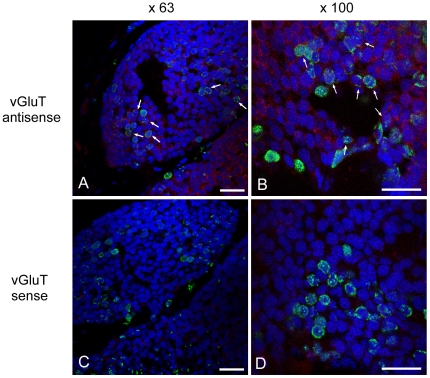
Double staining of BrdU and vGluT mRNA.(A, B) Confocal images of sections dually stained by anti-BrdU antibody (green) and an antisense riboprobe against vGluT mRNA (red). Nuclei were stained with DAPI (blue). Arrows indicate BrdU-positive nuclei surrounded by a vGluT signal as demonstrated by in situ hybridization. (C, D) No signal is detected by a sense probe against vGluT mRNA. Magnifications of objective lenses were 63× (A, C) or 100× (B, D). Scale bars: 20 µm.